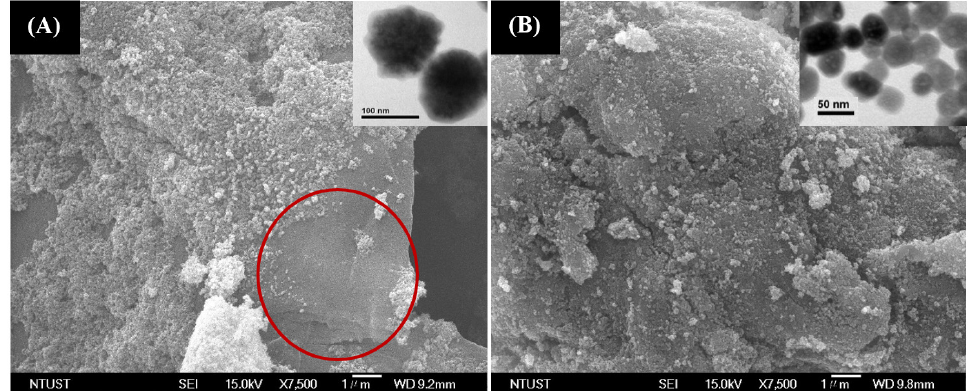
Figure 2. FE-SEM images of ( A ) magnetic biocomposite (B-M), the red circle indicates less magnetic area; and ( B ) amine magnetic biocomposite (B-MNH 2 ).